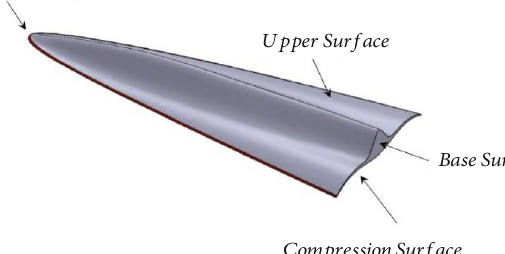
Figure 7: Isometric view of the WR2-G 2 con fi guration.